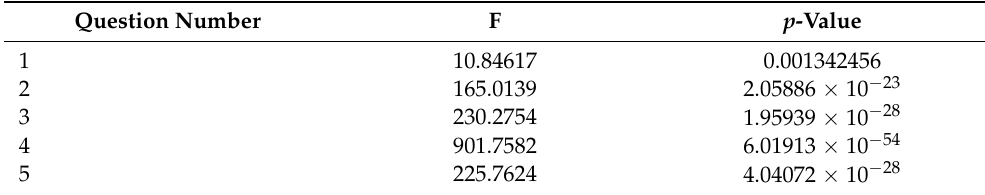
Figure 11. Distributions of answers to questions. The analysis of variance confirmed the significance of the teaching methodology factor at the p = 0.05 significance level (Table 3). Table 3. The results of the dispersion analysis of the survey.